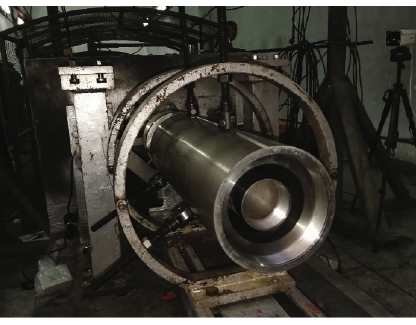
Figure 6: Scramjet engine. Table 4: Experimental conditions.